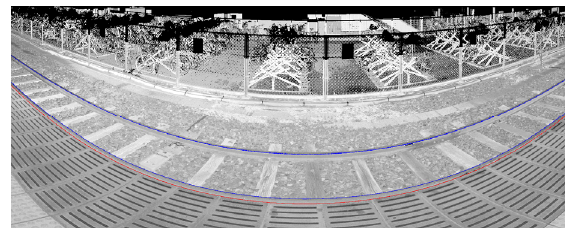
Figure 18. Virtual edges of the platform (red dots) and side points of the rails (blue dots)